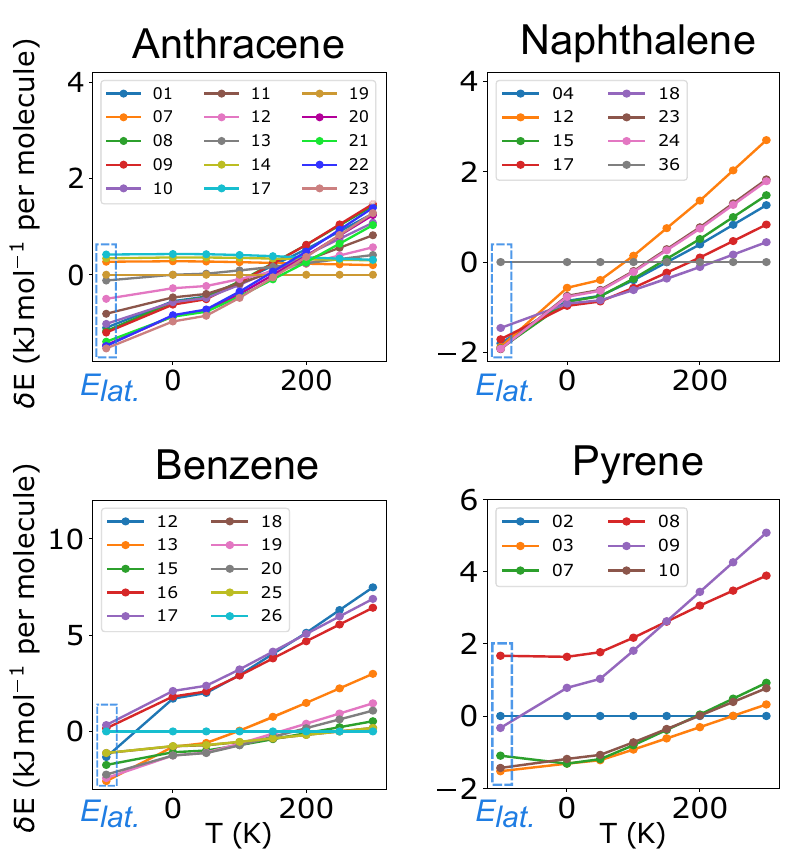
Fig. 4 Lattice energy E lat. and predicted free energy differences between variants of four molecular crystal families: anthracene, naphthalene, benzene, and pyrene. Full data, also for a larger number of crystals and polymporphs, is available in the Table S2 in the SI. Relative energies are calculated separately at each temperature, always with respect to the lowest free energy structure at 300 K. The numbers on the labels represent the identi fi ers of the crystals following the convention used in CCDC 56